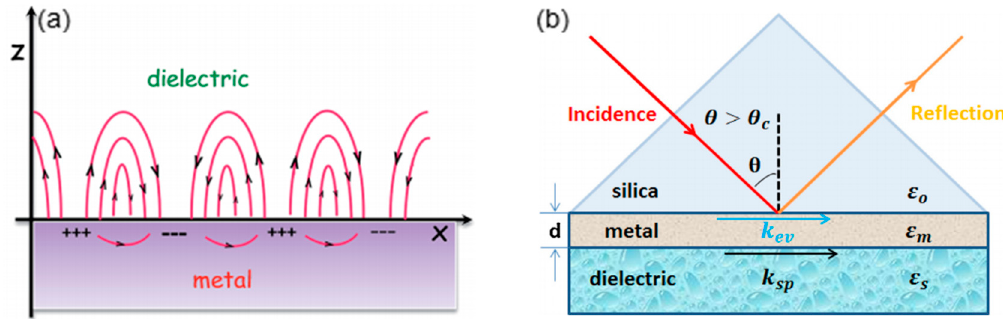
Figure 1 . ( a ) The propagating surface plasmon polariton (SPP) at the metal–dielectric interface (Figure adapted with permission from reference [4]). ( b ) The schematic illustration of conventional Kretschmann-Raether prism configuration (Figure adapted with permission from reference [5]) .